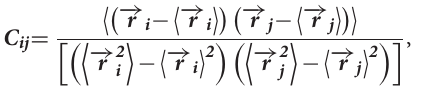
Frontiers in Chemistry |